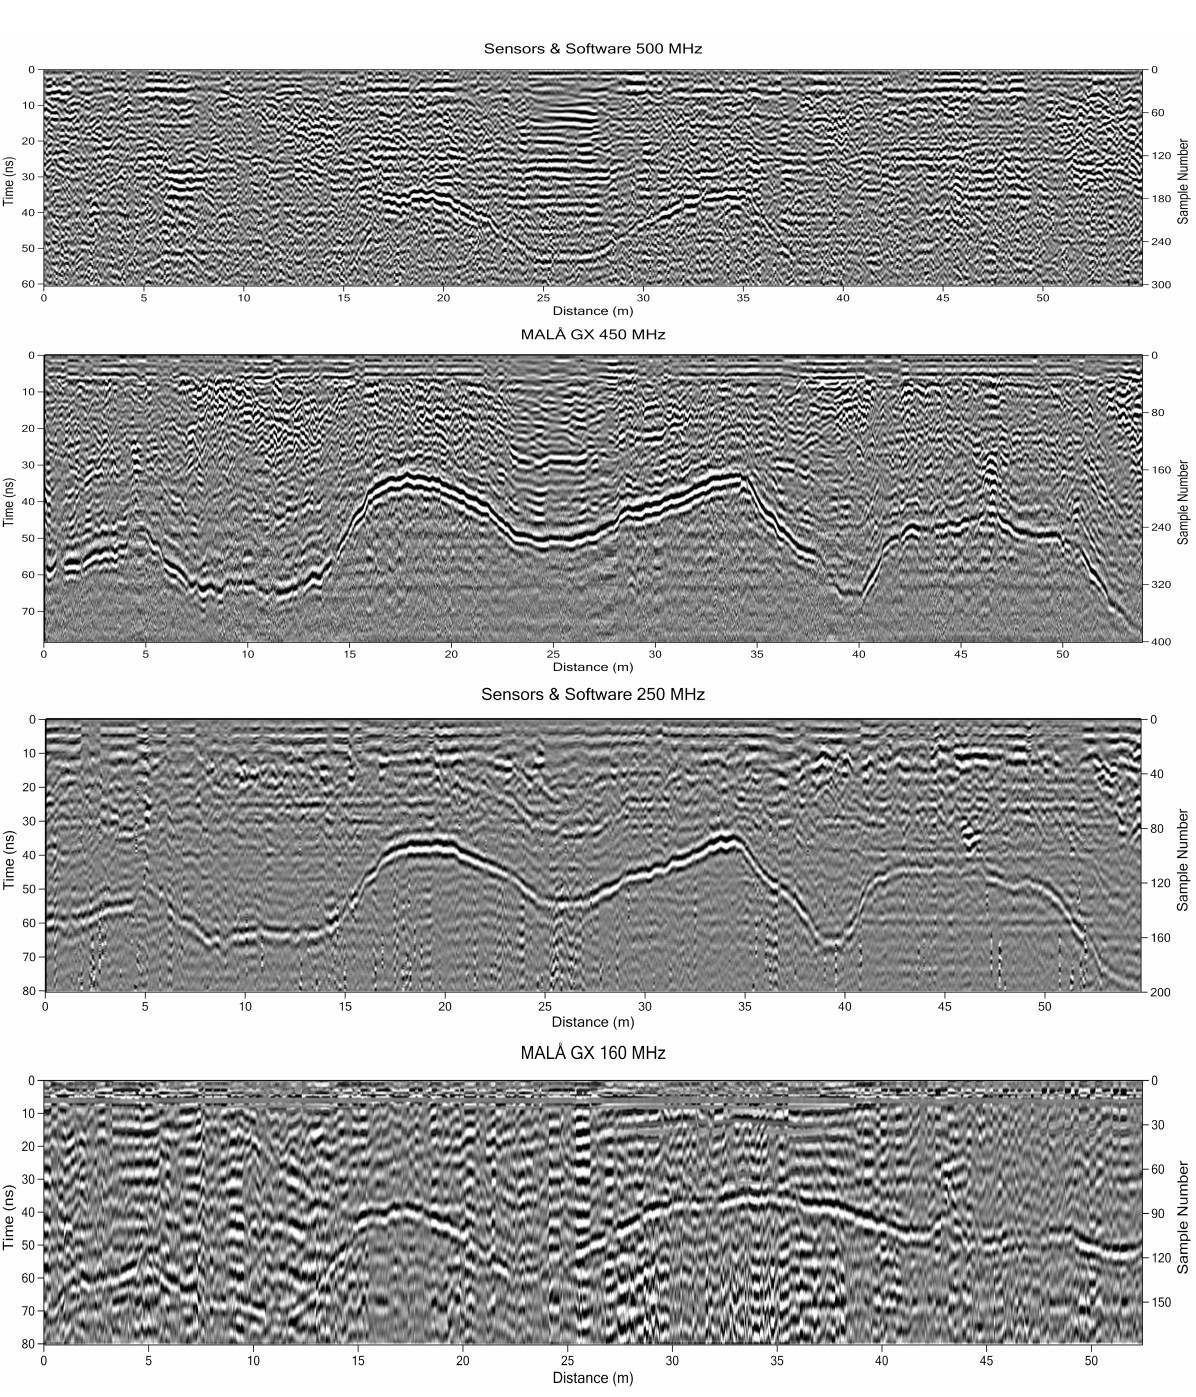
Figure 4. Comparison of GPR profiles from the survey area at Farriseidet acquired with different GPR antennae. All profiles show the reflection from the top of the bedrock, as well as internal structures in the peat. From top to bottom: Sensors & Software Noggin Plus 500MHz, MALÅ GX 450MHz, Sensors & Software Noggin Plus 250MHz, MALÅ GX 160MHz. Note that the 500MHz data were only recorded down to 60ns, and that the 160MHz profile was recorded along a slightly deviating track (parallel but 3m to the south of the other profiles), which explains the difference in the appearance of the bedrock reflection. While the 450 MHz appears as a good compromise regarding imaging resolution and depth penetration, all antennae worked well in the waterlogged soil, and under more controlled circumstances, the data quality of all systems would be expected to be much greater. Images were generated with GPR Viewer , courtesy of Larry